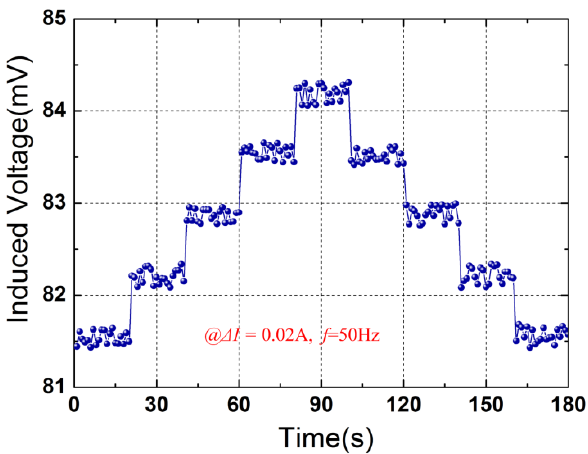
Figur e 7. Output voltage as a function of time under small current step changes.